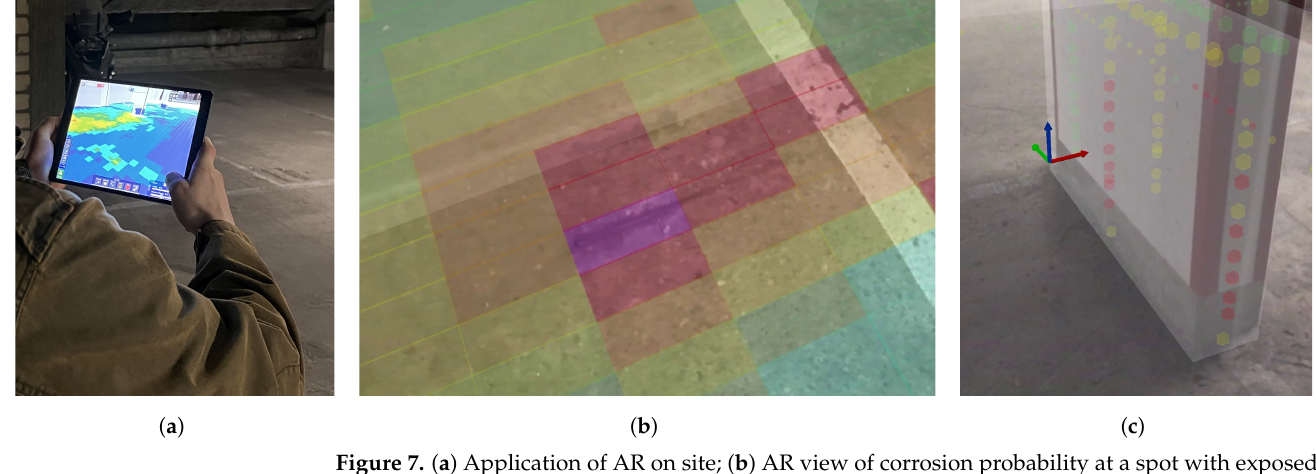
Figure 7. ( a ) Application of AR on site; ( b ) AR view of corrosion probability at a spot with exposed rebar; ( c ) concrete cover of rebars in a